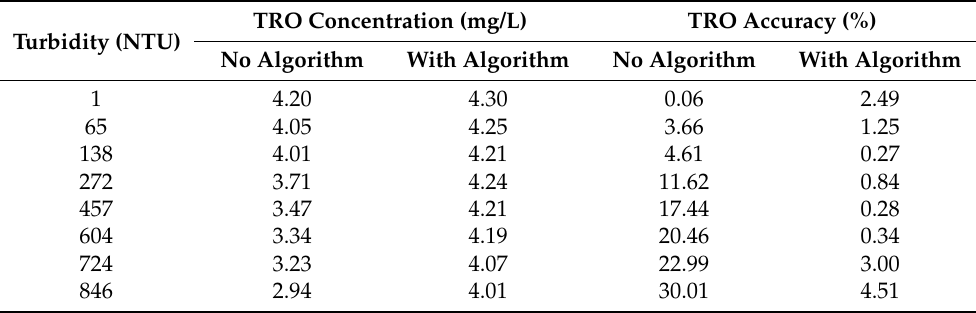
Table A2. TRO concentration and accuracy by turbidity with or without the proposed algorithm at 4.2 mg/L TRO